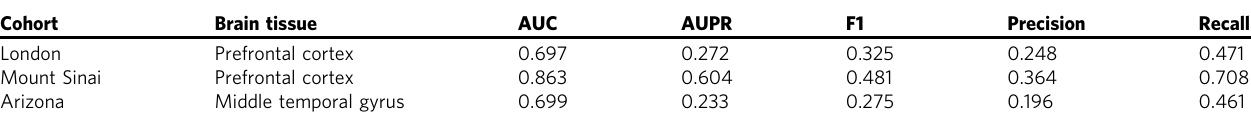
Table 4 Summary of performance evaluation on three additional cohorts of samples: London, Mount Sinai, and Arizona. Cohort Brain tissue Recall